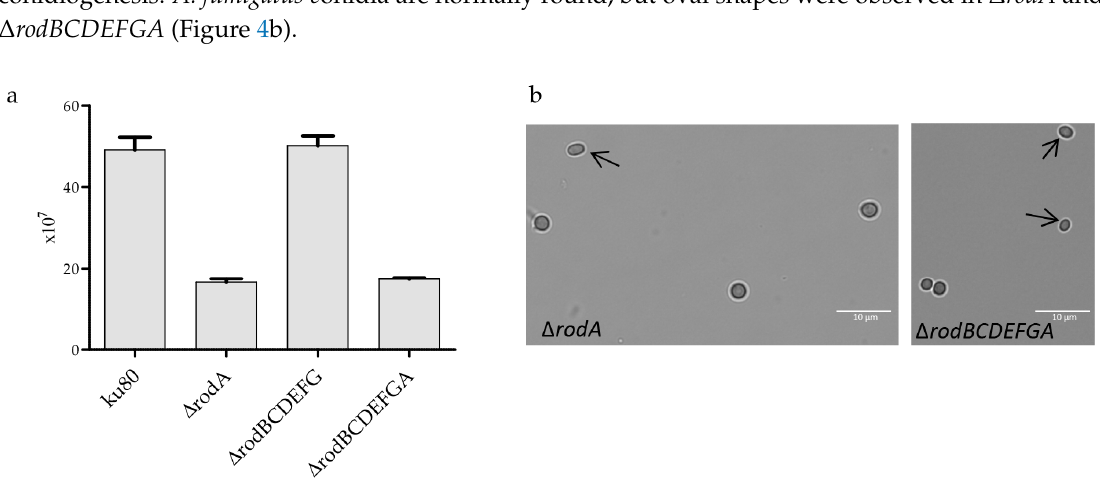
Figure 4. Conidiation of hydrophobin mutants. Sporulation of ku80 and hydrophobin mutants, quantification of the amount of conidia was conducted from three different malt agar slants ( a ); morphology of RODA deleted conidia, showing some conidia with an oval shape (arrow) ( b ).